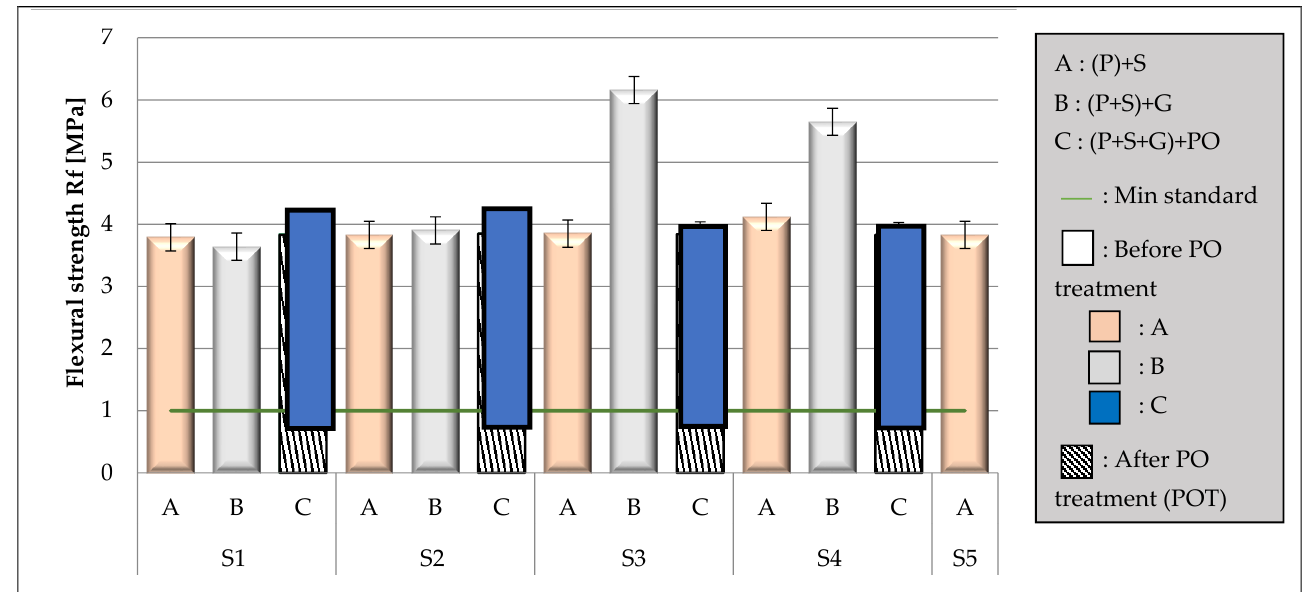
Figure 9. Variation in flexural strength of composites in the different mixing plans.